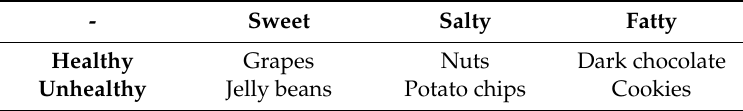
Table 3. The six snacks used in the study divided into categories.